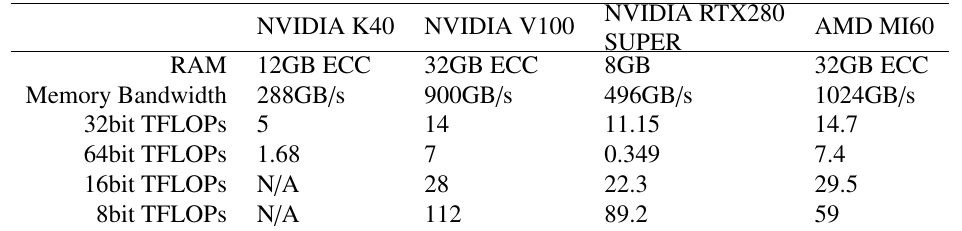
Table 1. Capabilities and performance of selected